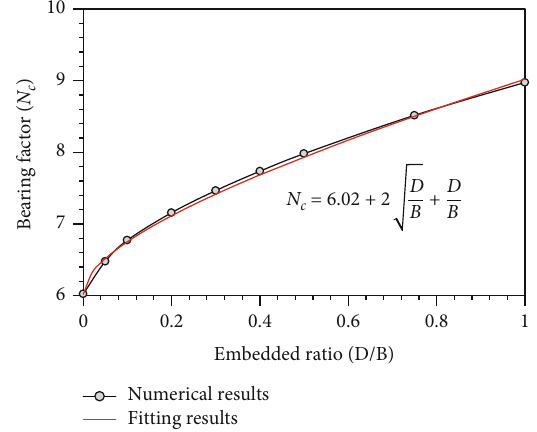
Figure 8: Fitting curve of N